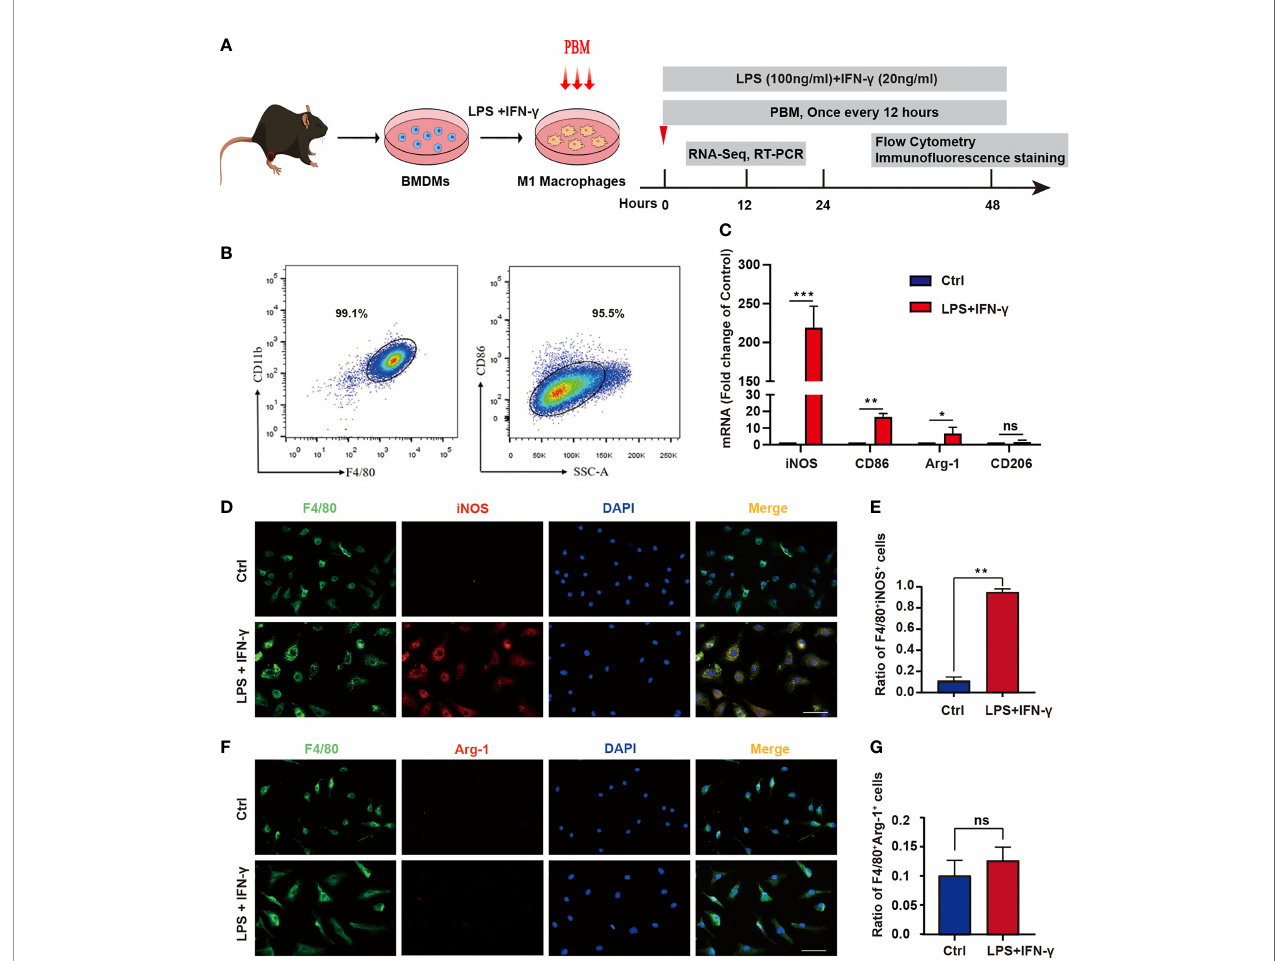
FIGURE 2 | Identi fi cation of BMDMs and induction of neurotoxic macrophages. (A) Schematic diagram of extraction of mouse BMDMs and induction of M1-type polarization and timeline of the experimental design. (B) BMDMs were identi fi ed by examining the macrophage markers F4/80 and CD11b using fl ow cytometry. (C) The expression of M1 markers (iNOS and CD86) and M2 markers (Arg1 and CD206) was detected by RT – PCR in the control group and the LPS + IFN- g -treated group. (D) Immuno fl uorescence staining was used. Red: the M1 macrophage marker iNOS; green: the macrophage marker F4/80; blue: DAPI (nucleated cells) in untreated and LPS + IFN- g -treated cells. Scale bar = 50 mm. (E) The ratio of F4/80 + iNOS + cells in the control group and in the LPS- and IFN- g -treated groups. (F) Immuno fl uorescence staining was used. Red: the M2 macrophage marker Arg1; green: the macrophage marker F4/80; blue: DAPI (nucleated cells) in untreated and LPS + IFN- g -treated cells. Scale bar = 50 mm. (G) The ratio of F4/80 + Arg1 + in the control group and in the LPS- and IFN- g -treated groups (all experiments in this group were independently repeated three times). *P < 0.05, **P < 0.01, ***P < 0.001; ns, not signi fi